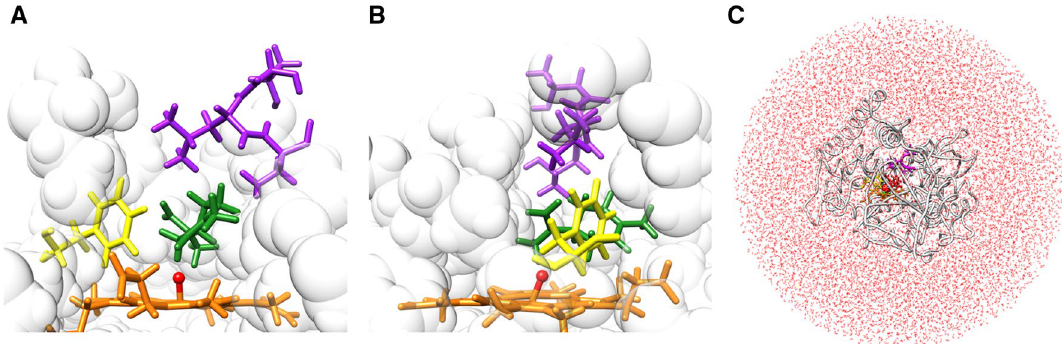
Figure 4. ( A ) A tentative complex conformation of the ( S )-(−)-limonene docked into the BMP X-ray crystal conformation with the resolution of 1.65 Å (PDB ID: 1BU7) using ZDOCK software. The coordinates of the missing hydrogen atoms in the BMP crystal structure were automatically generated by an MD simulation program PRESTO ver. 3. See the legend in Fig. 3 for the coloring and representation in the figure. This conformation was used as a pre-initial conformation to generate the initial different conformations for 72 MD simulation runs. A view of the active site from the pocket entrance side. ( B ) A view of the active site from the F87 side. ( C ) The whole simulation system with water molecules and ions.